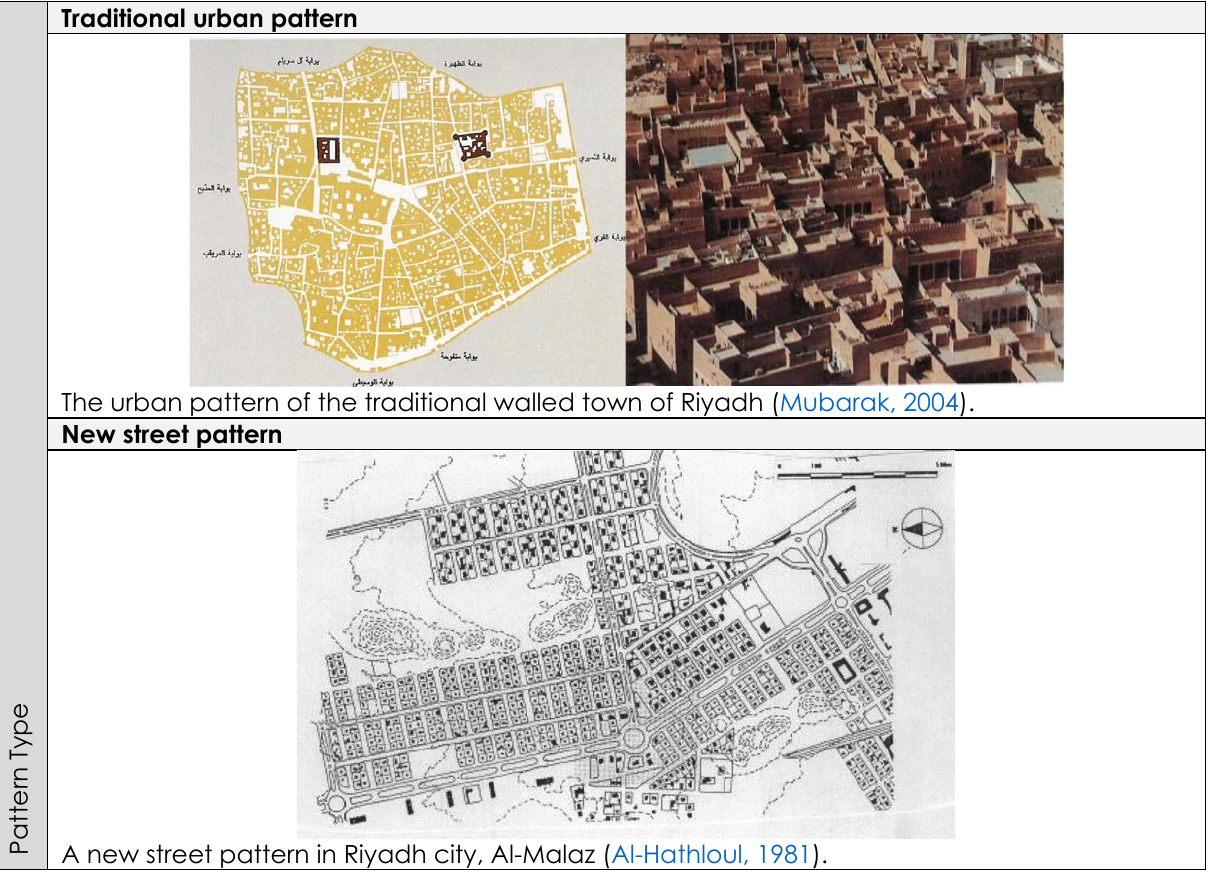
Table 7. Historical development of Riyadh.